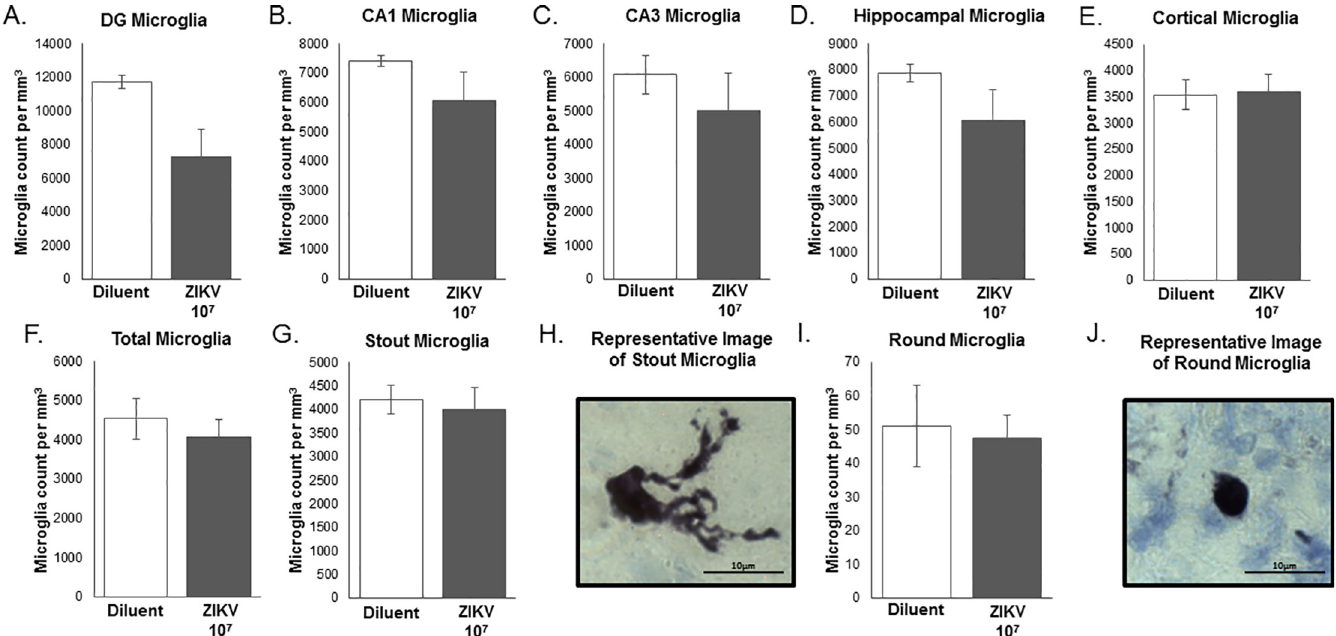
Fig 5. Investigation of microglial number and activation in hippocampal and cortical brain regions on postnatal day 2 in pups born of moms treated with ZIKV 10 7 or diluent control. (A) There was a trend in the DG (F 1,10 = 3.865, P = 0.078), indicating there are fewer microglia present in the ZIKV group compared to the diluent control group, though this effect was not significant. There was no significant effect of ZIKV infection on microglial numbers in ( B ) the CA1 of the hippocampus, ( C ) the CA3 of the hippocampus, ( D ) the hippocampus overall, ( E ) the cortex, ( F ) or in the analysis of all brain regions combined. Statistical analysis of microglial morphology revealed no significant difference in microglial morphology between treatment groups ( G , Stout Microglia: F 1,10 = 0.136, P = 0.720; H , Round Microglia: F 1,10 = 0.067, P = 0.801). n = 6 animals per group. � : p < 0.05. (63X magnification, scale bar = 10 μ